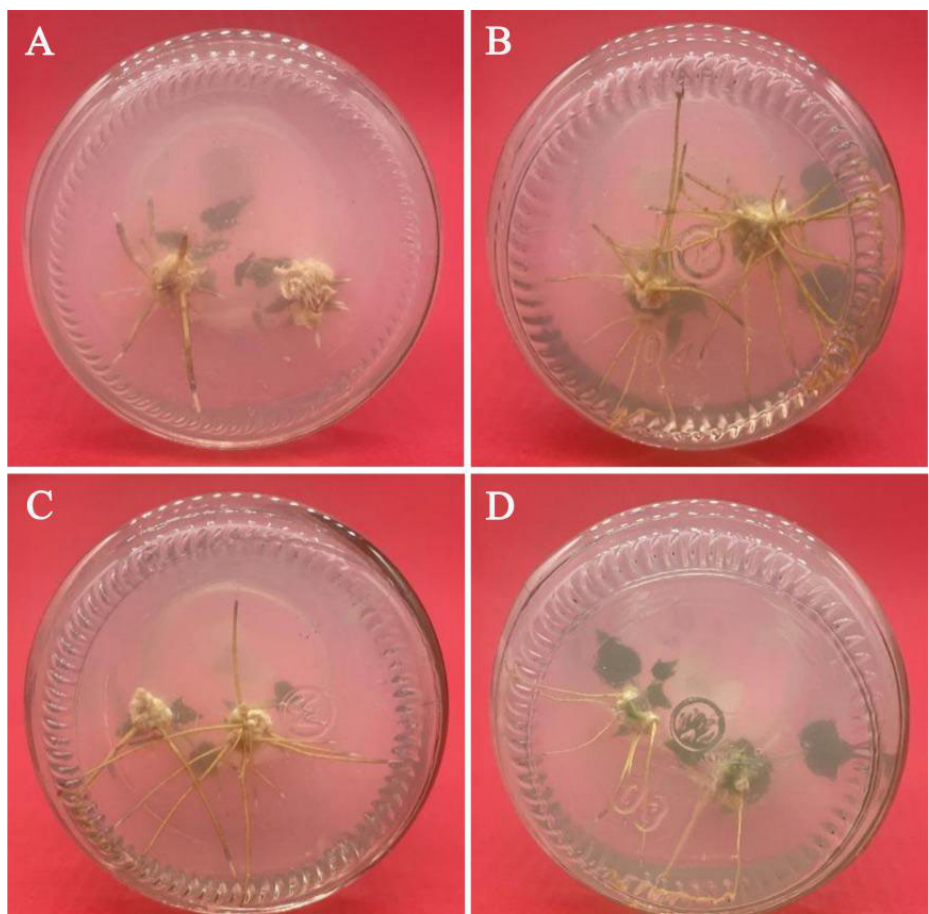
Figure 5. Rooting of adventitious shoots on medium with different NAA concentrations: ( A ) 1/2 MS medium supplemented with 0 mg/L NAA; ( B ) 1/2 MS medium supplemented with 0.1 mg/L NAA; ( C ) 1/2 MS medium supplemented with 0.2 mg/L NAA; and ( D ) 1/2 MS medium supplemented with 0.5 mg/L NAA.